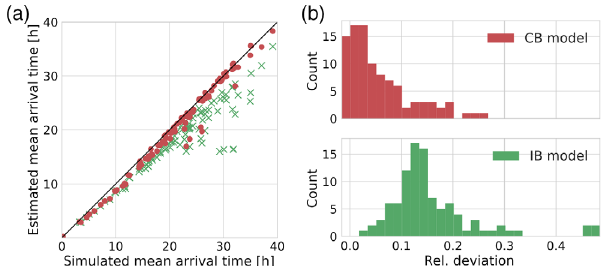
FIG. 14. (a) Comparison between simulated and estimated mean infection arrival times. We extend the data set periodically in time until the outbreak dies out. The discrete derivative of the cumulative infection probabilities (see Fig. 2) yields the infection arrival probabilities of which we take the average value for every node. Results according to the CB and IB models are visualized as red circles and green crosses, respectively. The epidemic starts from the same outbreak origin and disease parameters as in Fig. 1. (b) Histogram over the relative deviation from the simulated infection arrival times. The numerical values are averaged over 10 5 realizations.